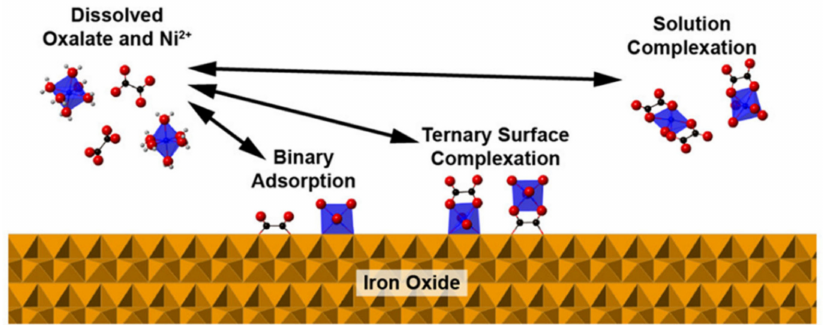
Figure 8. Ternary adsorption. Image adopted from Flynn and Catalano [138] with permission. Aqueous Ni-oxalate complexation is also